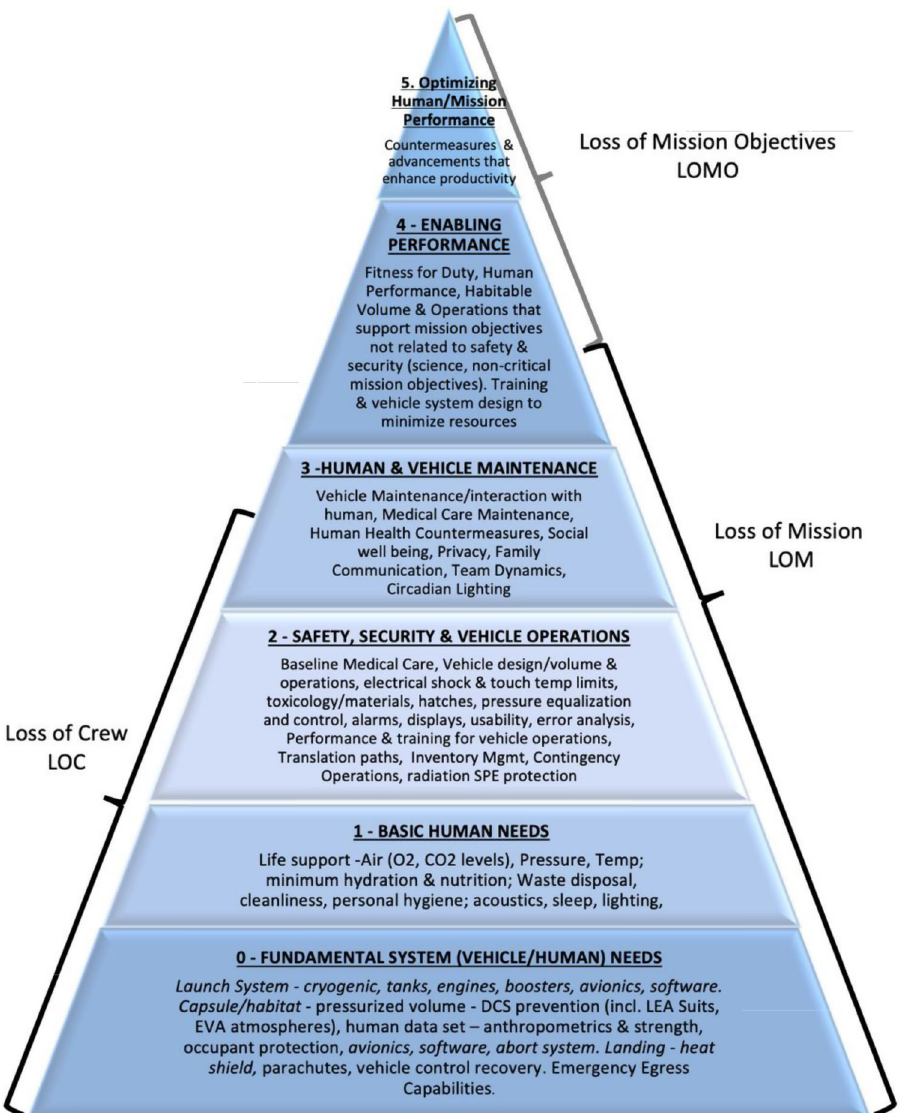
Fig. 3 Human space fl ight standards hierarchy pyramid. The purpose of this pyramid is to provide a top-level view of technical requirements and how each subsection impacts a mission ’ s